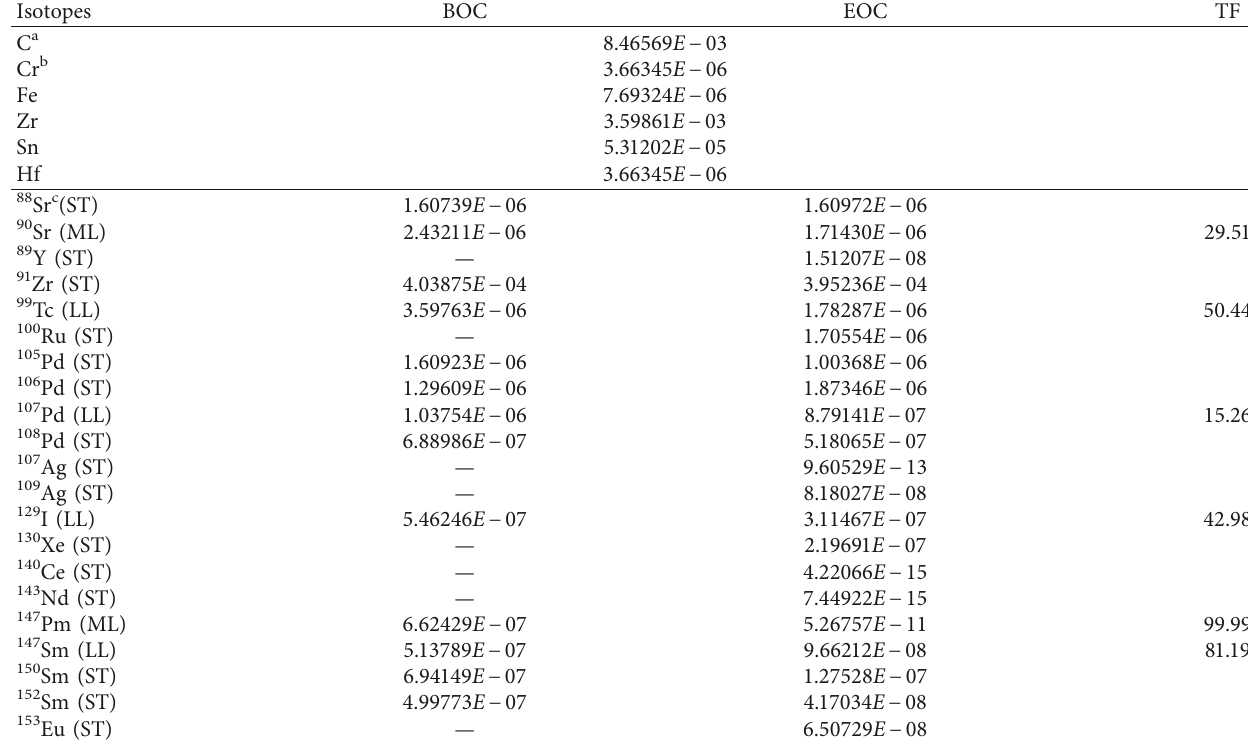
Table 4: Atomic densities of fission products in the spent fuel case of C (atoms/(barn · cm)) and transmutation fractions (%). Isotopes BOC EOC TF C